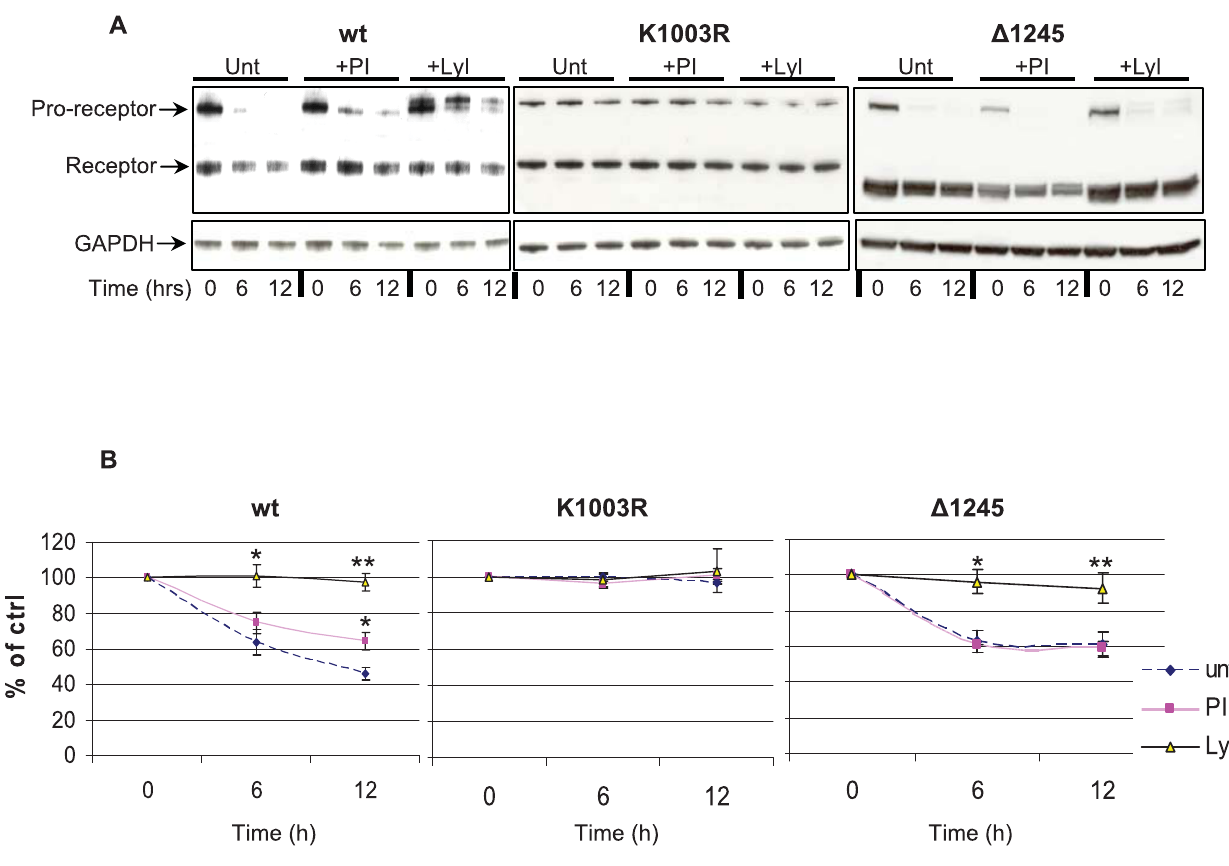
Figure 5. IGF-1R is degraded through both proteasomes and lysosomes. A. Wt, K1003R, and D 1245 were either untreated (Unt) or pre-incubated with epoxomicin (PI) or chloroquine (LyI) as described in Materials and methods. Cycloheximide (CHX) (50 m g/ml) was added and the cells were further incubated for 6 or 12 h. The cells were lyzed and subjected to SDS-PAGE and western blotting with antibody to IGF-1Rß. The proreceptor and 95 kDa b -subunit of IGF-1R is indicated. B shows quantified data of IGF-1R, as normalized with GAPDH. Means and SDs of three separate experiments are shown. * P, , 0.05 ; ** P, , 0.005 .